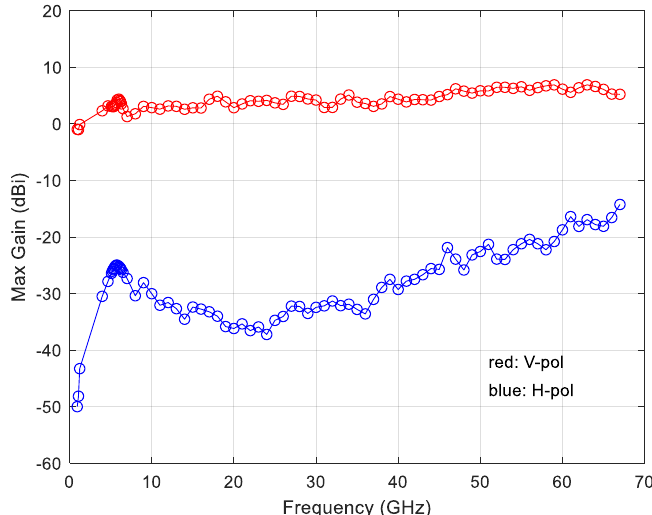
Figure 11. The calculated base MBA maximum gains.